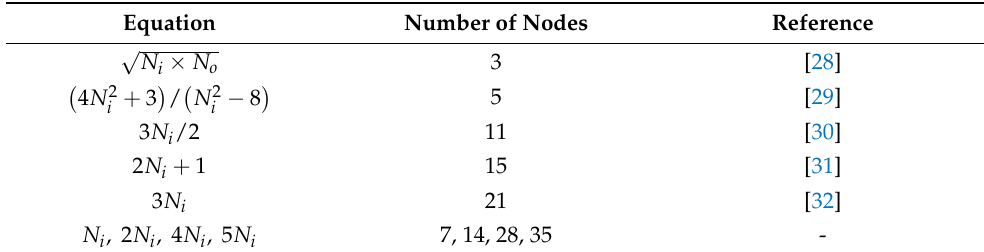
Table 4. Equations for determination of the number of nodes.